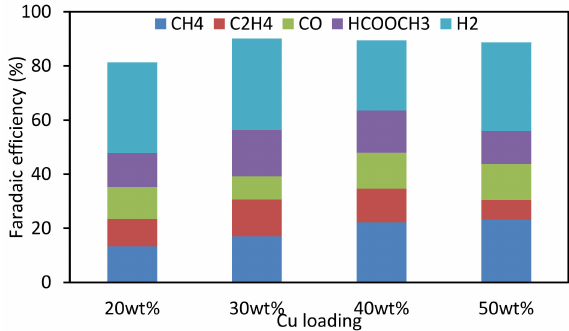
Figure 6. Influence of Cu loading on the Faradaic efficiencies of products during the electrochemical reduction of CO 2 . Potential: − 1.9 V, catholyte: 0.15 M of NaCl in methanol.